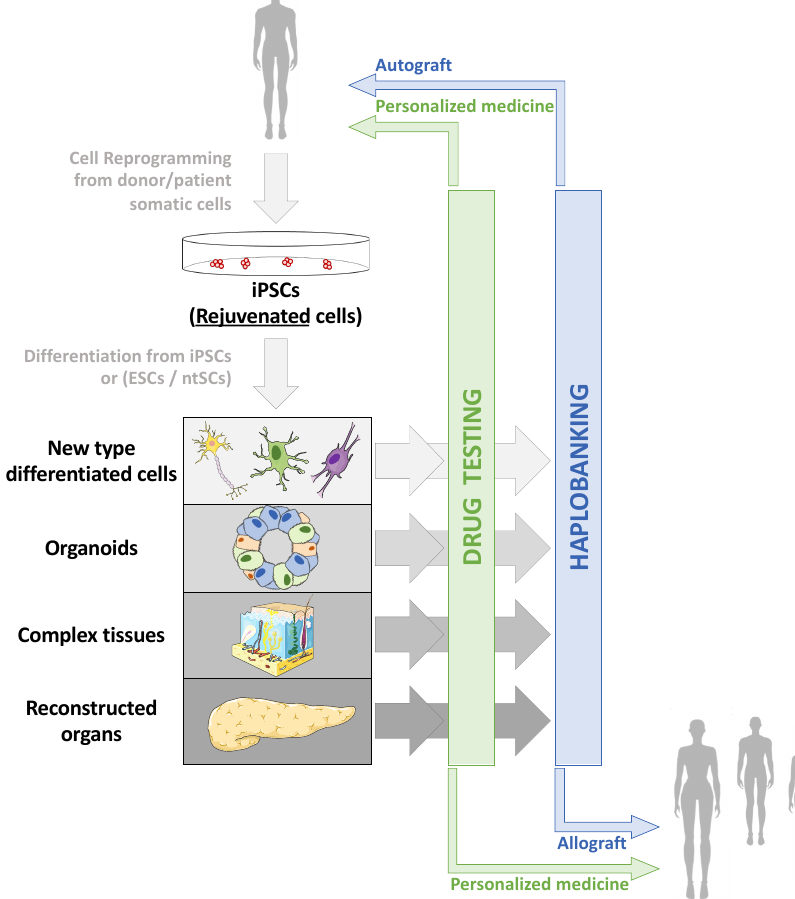
Figure 2. Applications of cell reprogramming and hPSCs to restore altered or aged tissues. Due to increased life expectancy and global population aging, two major health issues are arising: increased prevalence of age-associated pathologies whose mechanisms remain only partially explored and understood, and increased age-associated tissue deterioration and loss of function. Therefore, human pluripotent stem cells (hPSCs), including embryonic stem cells (ESCs), nuclear transfer stem cells (ntSCs) and induced pluripotent stem cells (iPSCs) emerged as tools to model both age-associated pathologies and tissue deterioration: from 2D cell culture to 3D complex reconstructed tissues, through organoids, and cells or tissue replacement strategies. Thanks to cell reprogramming [4,71], iPSCs made it possible to envisage autografts, especially in aged patients, as reprogramming erases aging marks in iPSCs and allows production of “rejuvenated” cells after differentiation